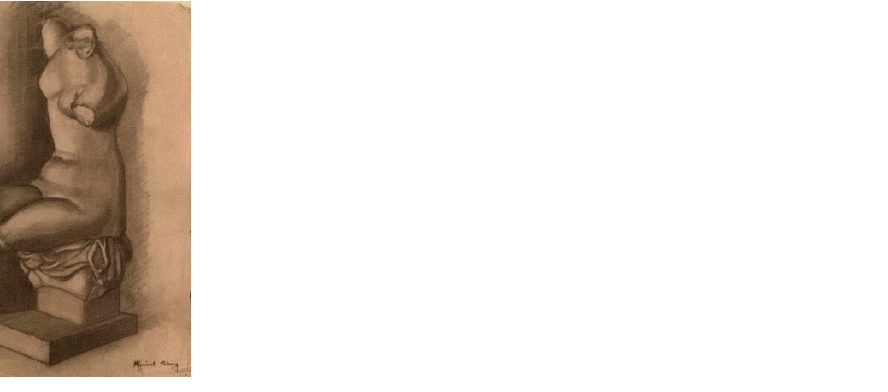
Figure 2. Menhat Helmy, Portrait of Bust (1947–1949). Courtesy of estate of Menhat Helmy.